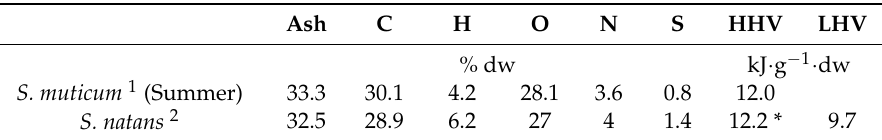
Table 1. Ultimate analysis of S. muticum and S. natans